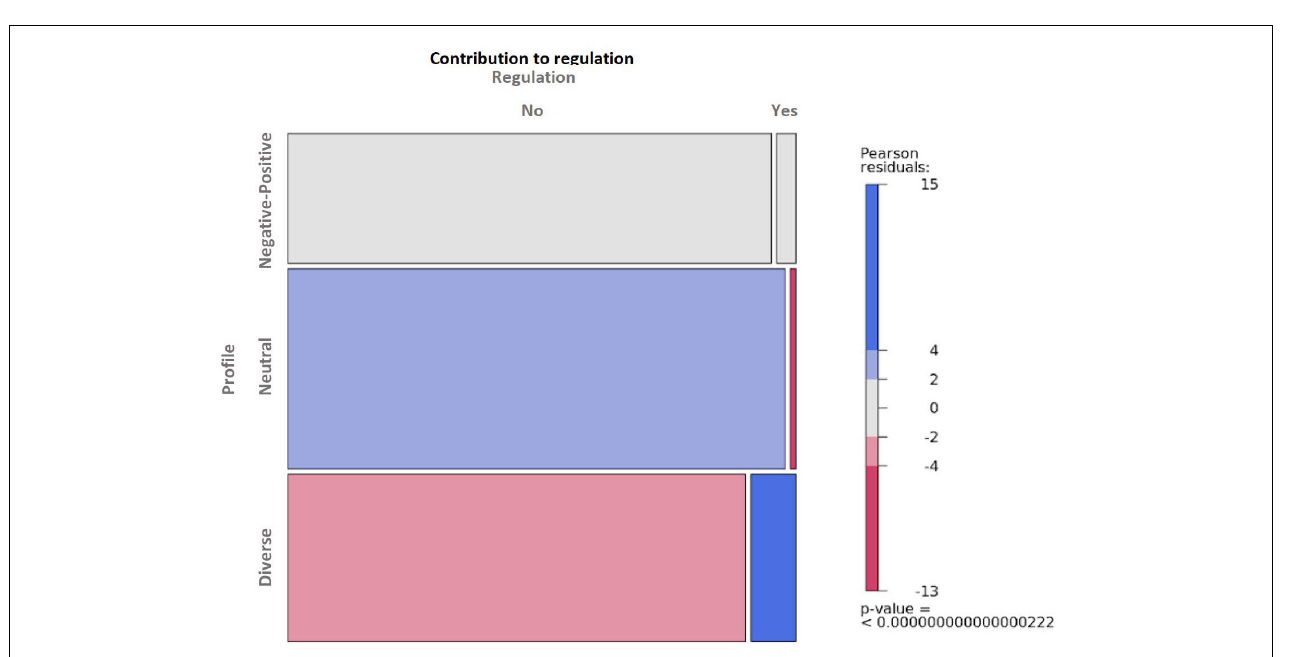
FIGURE 5 | Mosaic plots visualizing the association of the valence of participation and the emotional activation between the three socio-emotional interaction profiles.